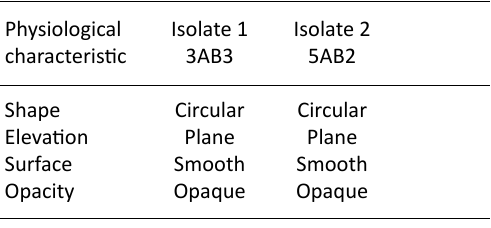
Fig. 2. Microplate Screening Assay. Table 3. Physiological characteristics of bacterial colonies obtained.